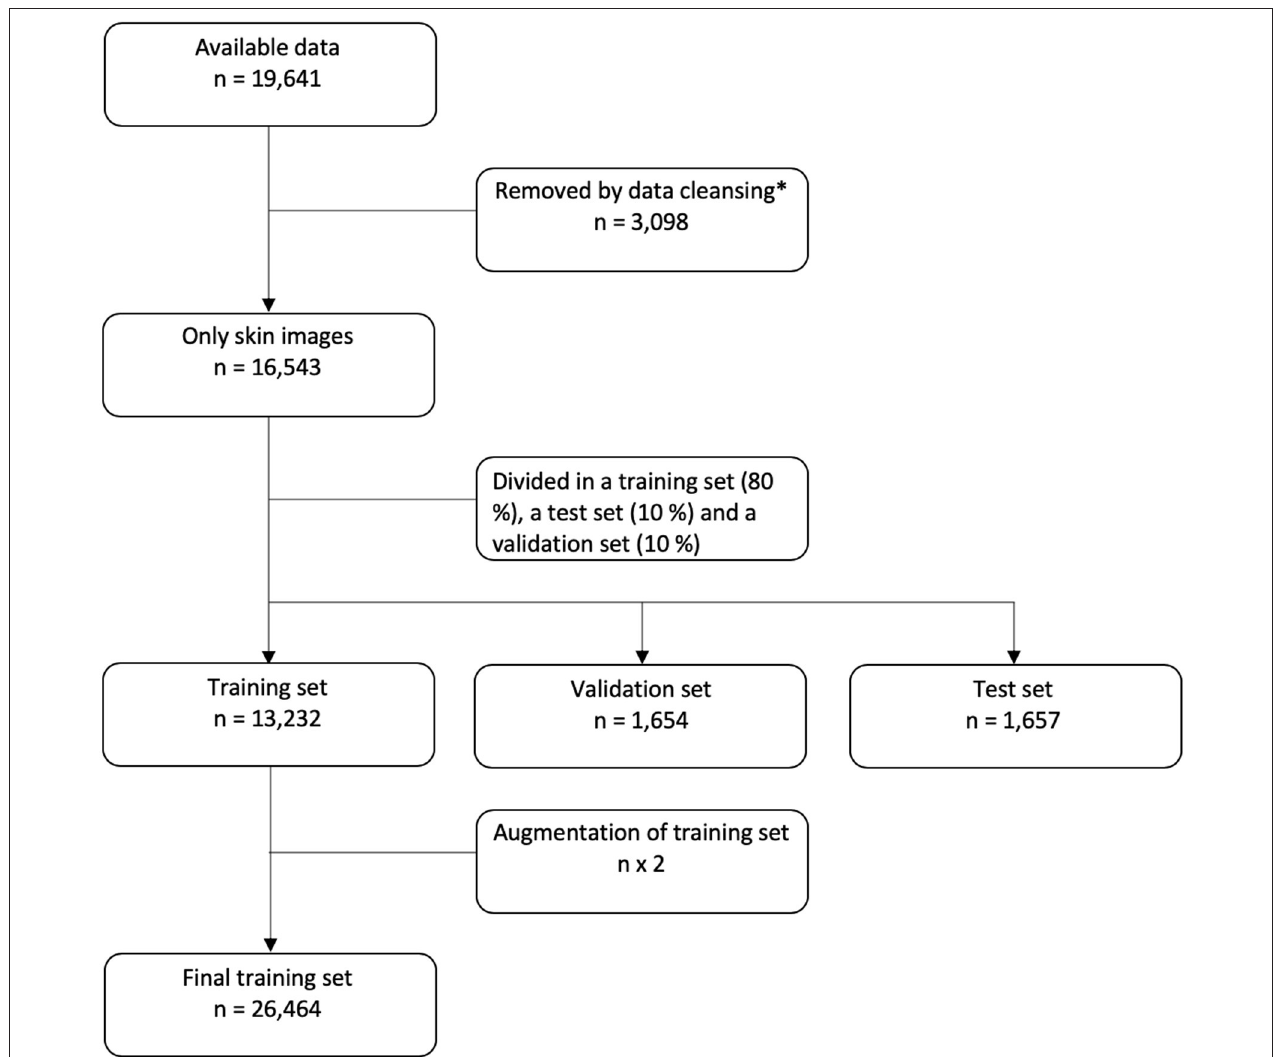
FIGURE 1 | Flowchart of data. *For details on data cleansing, please see the Supplementary Figure 1 .